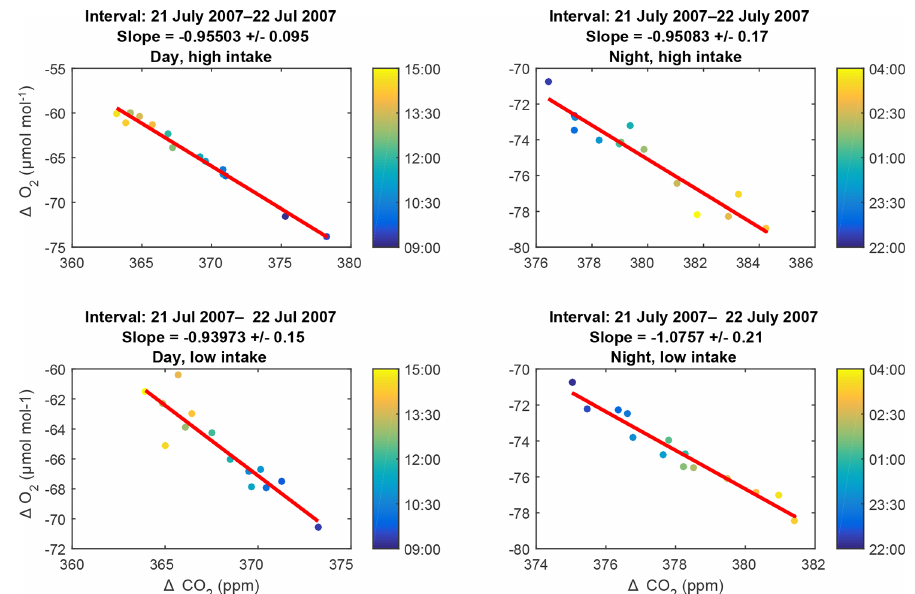
Figure 5. Representative examples of slope plots: data collected during day and night periods from the high and low intakes on 21–22 July 2007. The colors of the points indicate the time of collection within the 6h intervals, as keyed in the color bar to the right of each plot. Errors on the slopes are purely statistical.